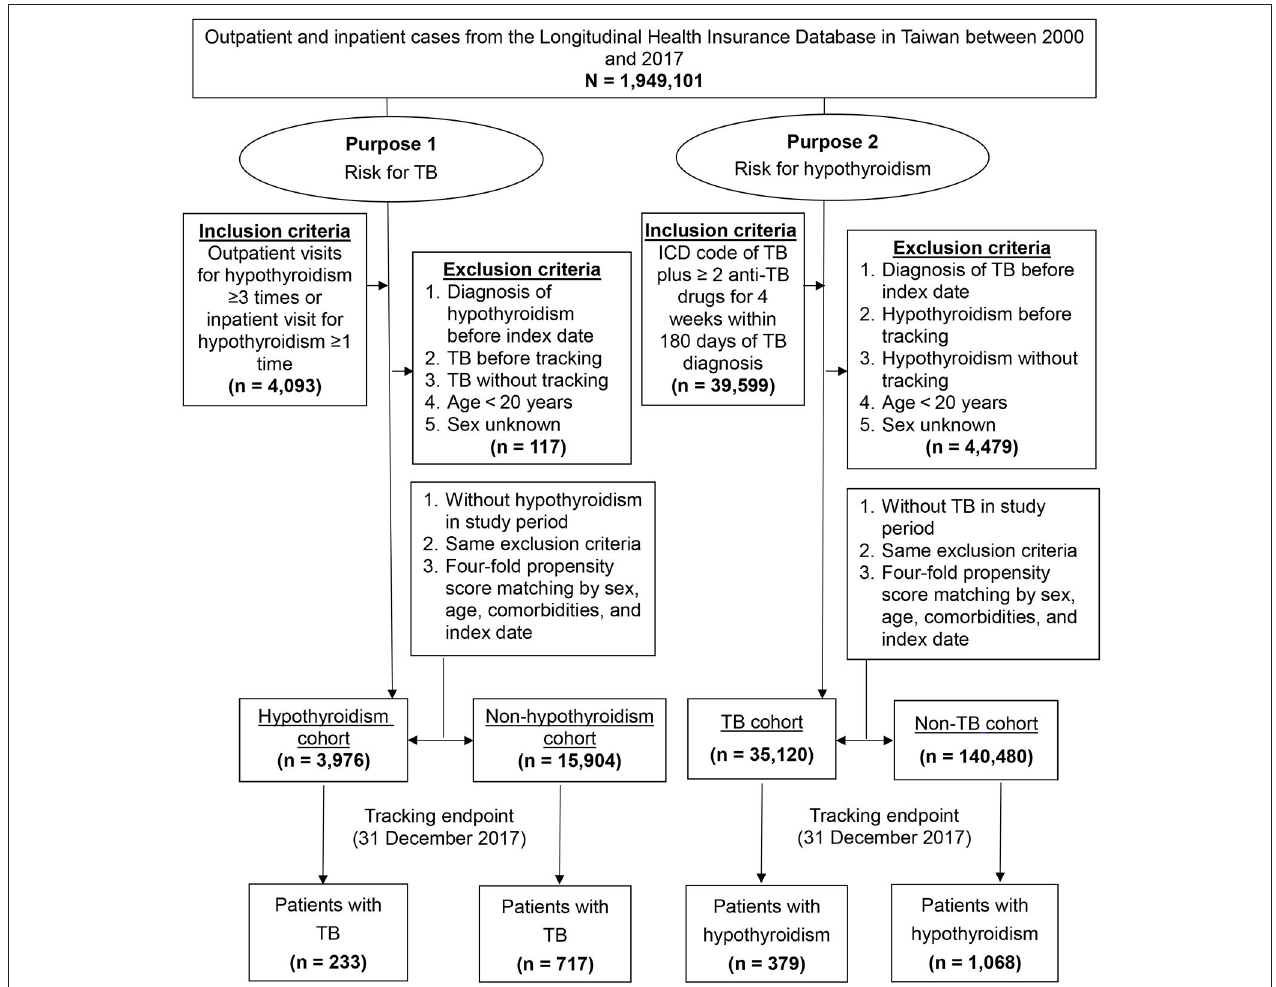
FIGURE 1 | Flowchart of study participant selection. ICD, International Classification of Disease; TB,